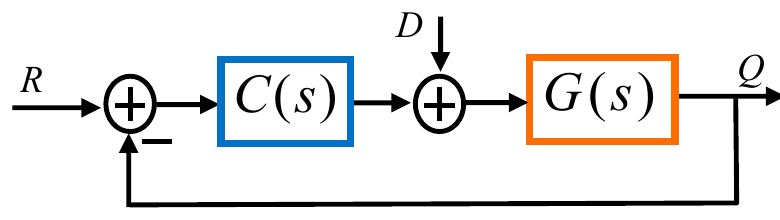
Figure 2. Block diagram of the closed-loop FOPID control